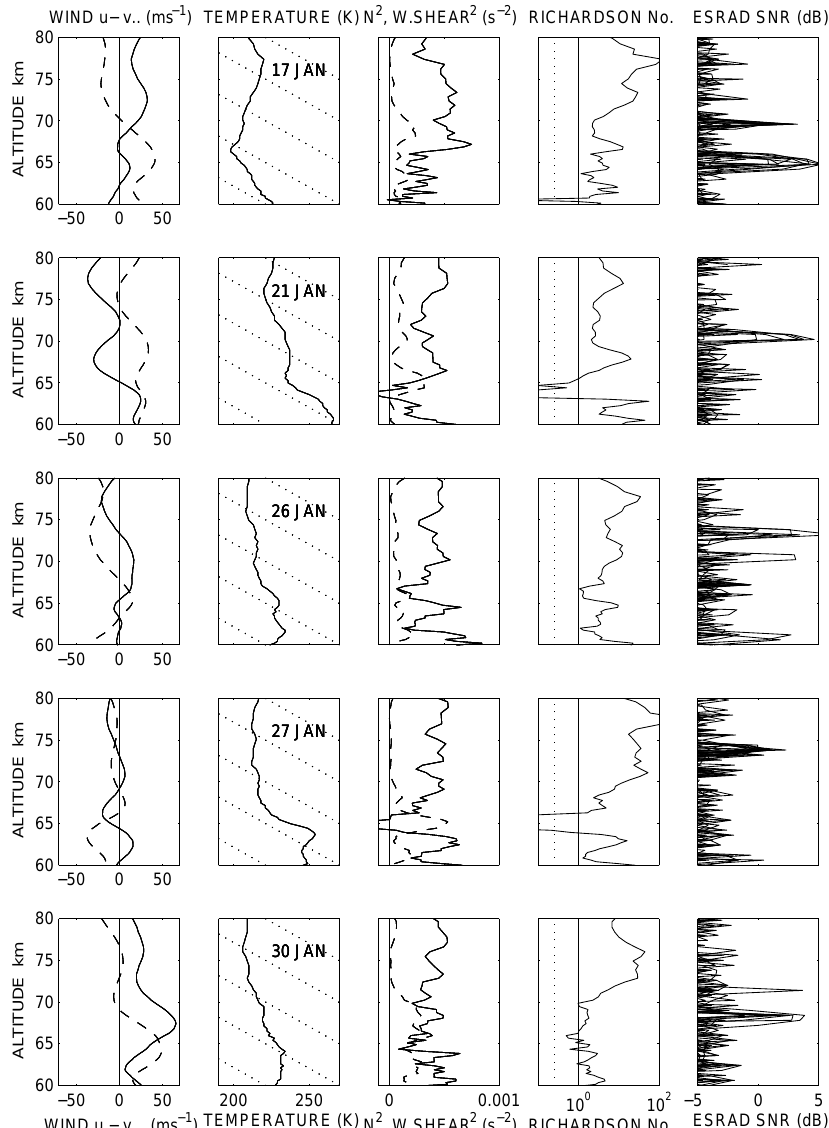
Fig. 4. Comparison of falling-sphere measurements (leftmost 4 panels in each row) and ESRAD observations of PMWE (rightmost panel in each row) on 17, 21, 26, 27 and 30 January. Leftmost panels show wind components (solid line: u, eastward wind, dashed line: v, northward wind) and temperature measured by the falling spheres (dotted lines indicate the adiabatic lapse rate, for comparison). The centre panels show the square of the wind-shear (dashed line), the square of the Brunt-Vaisala frequency, N 2 ( solid line), and the Richardson number, which is the ratio of the former two quantities. These parameters are derived from the falling-sphere measurements. Vertical lines on the panels showing Richardson number mark Ri =0.25 (dotted) and Ri =1 (solid). The right-hand panels show the ESRAD observations of PMWE for the time period from 30min before the time of the falling sphere measurements, up to the time of launch, and between 10–30min after launch. The period 0–10min after launch is excluded to avoid possible radar echoes from the rocket or from the